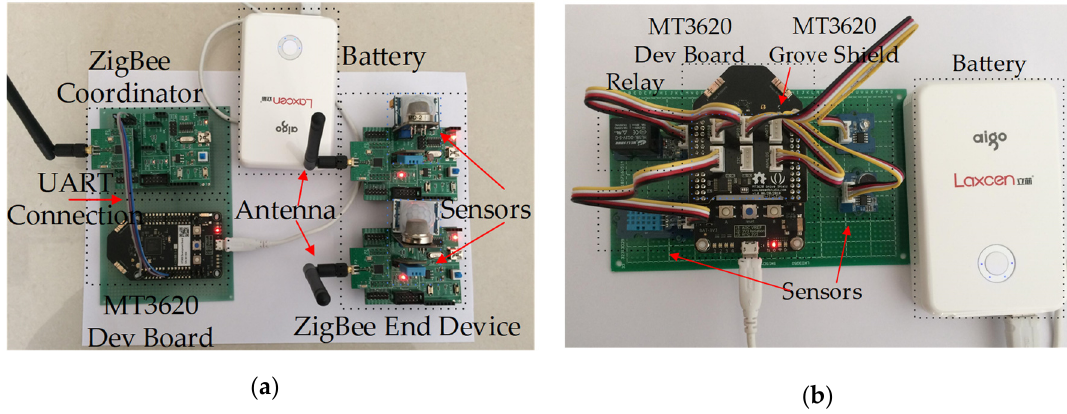
Table 3. Sensors and actuator used in this Figure 4. Hardware prototypes: ( a ) MT3620 as gateway device; ( b ) MT3620 as direct connect device.